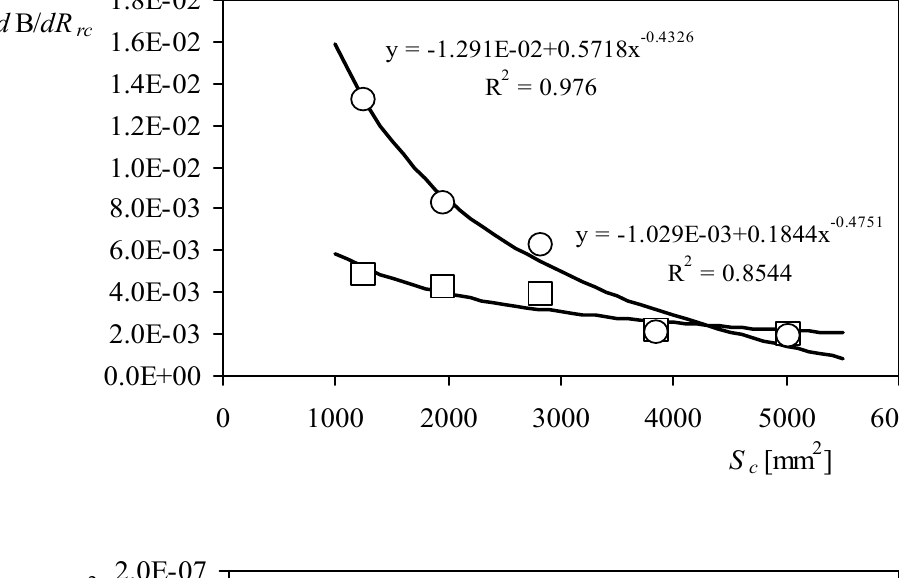
. Data correspond to the c